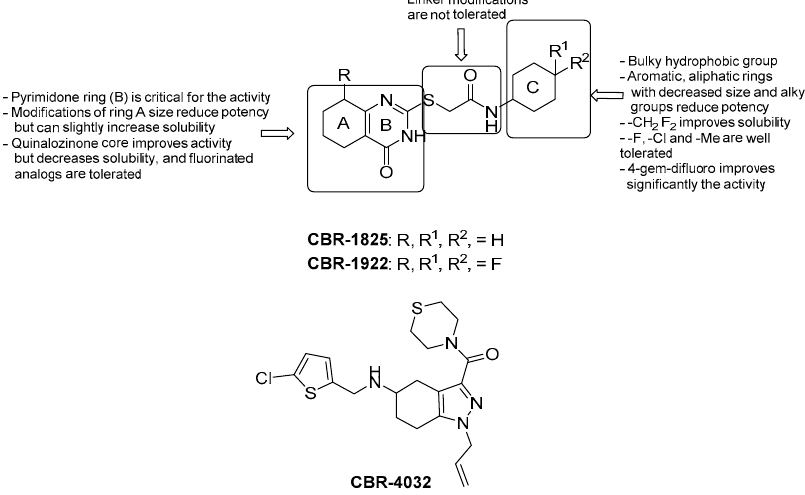
Figure 6. SARs of TQZ and THI and chemical structures of CBR-1825, CB-1922, and